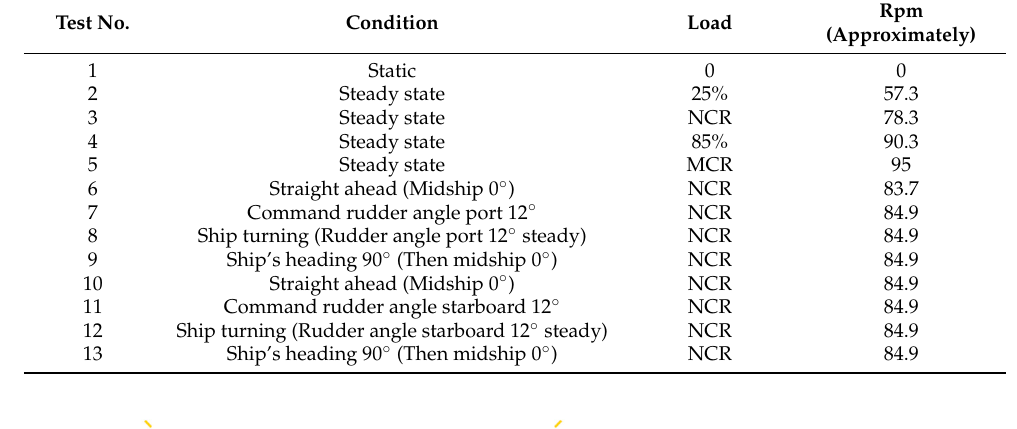
Table 3. Test conditions of the case study ship.